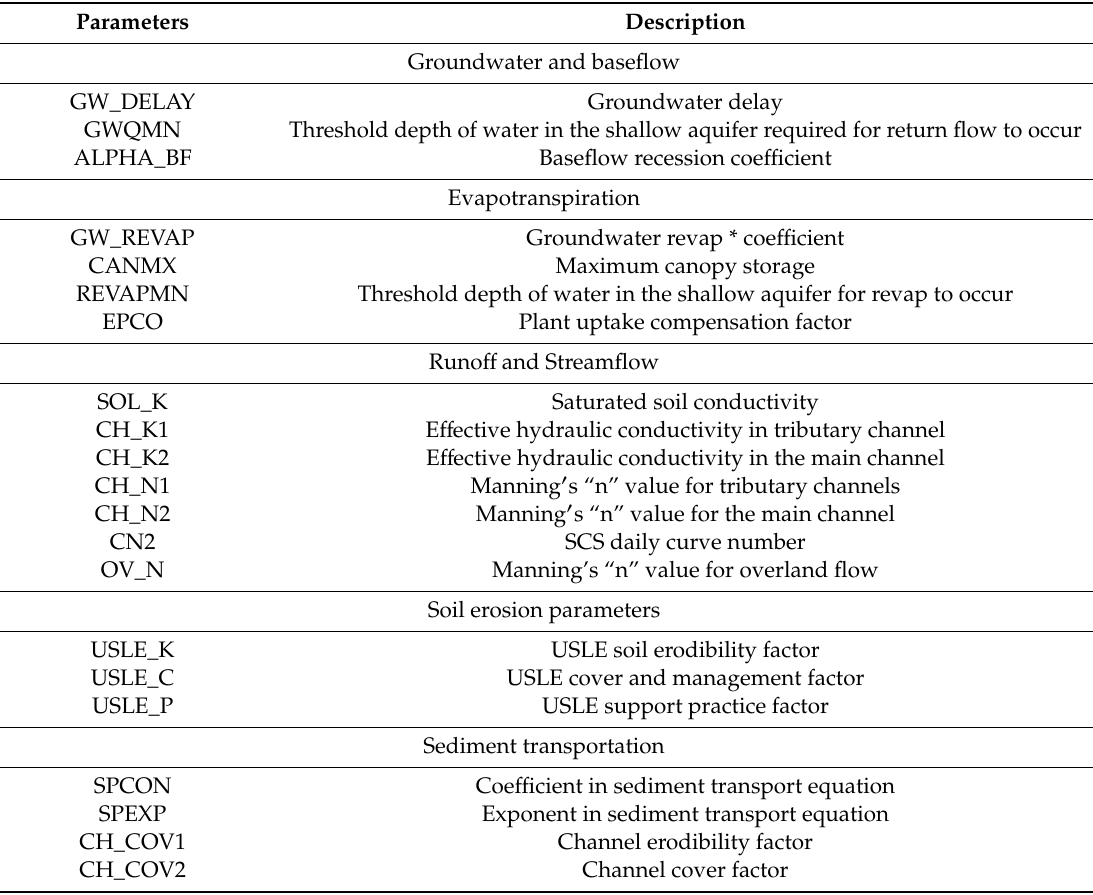
Table 2. Identified sensitive parameters involved in hydrological processes, soil erosion and sediment transport in the Soil and Water Assessment Tool (SWAT)